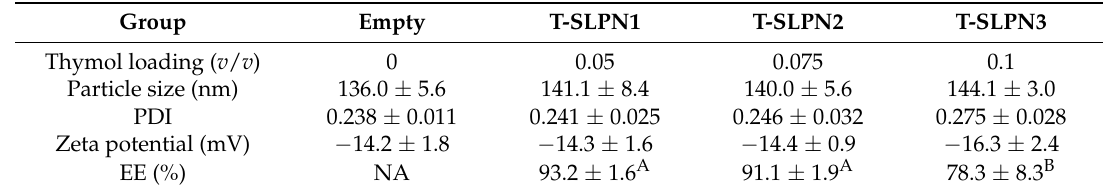
Table 1. Particulate characteristics of thymol loaded solid lipid–polymer hybrid nanoparticles (SLPN).